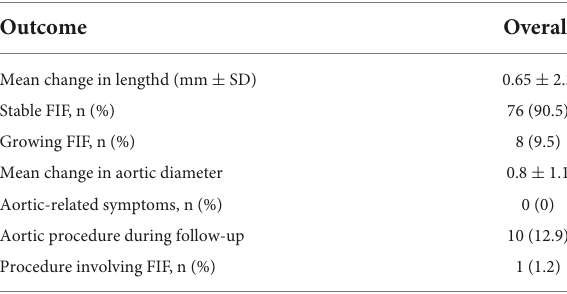
TABLE 3 Patient